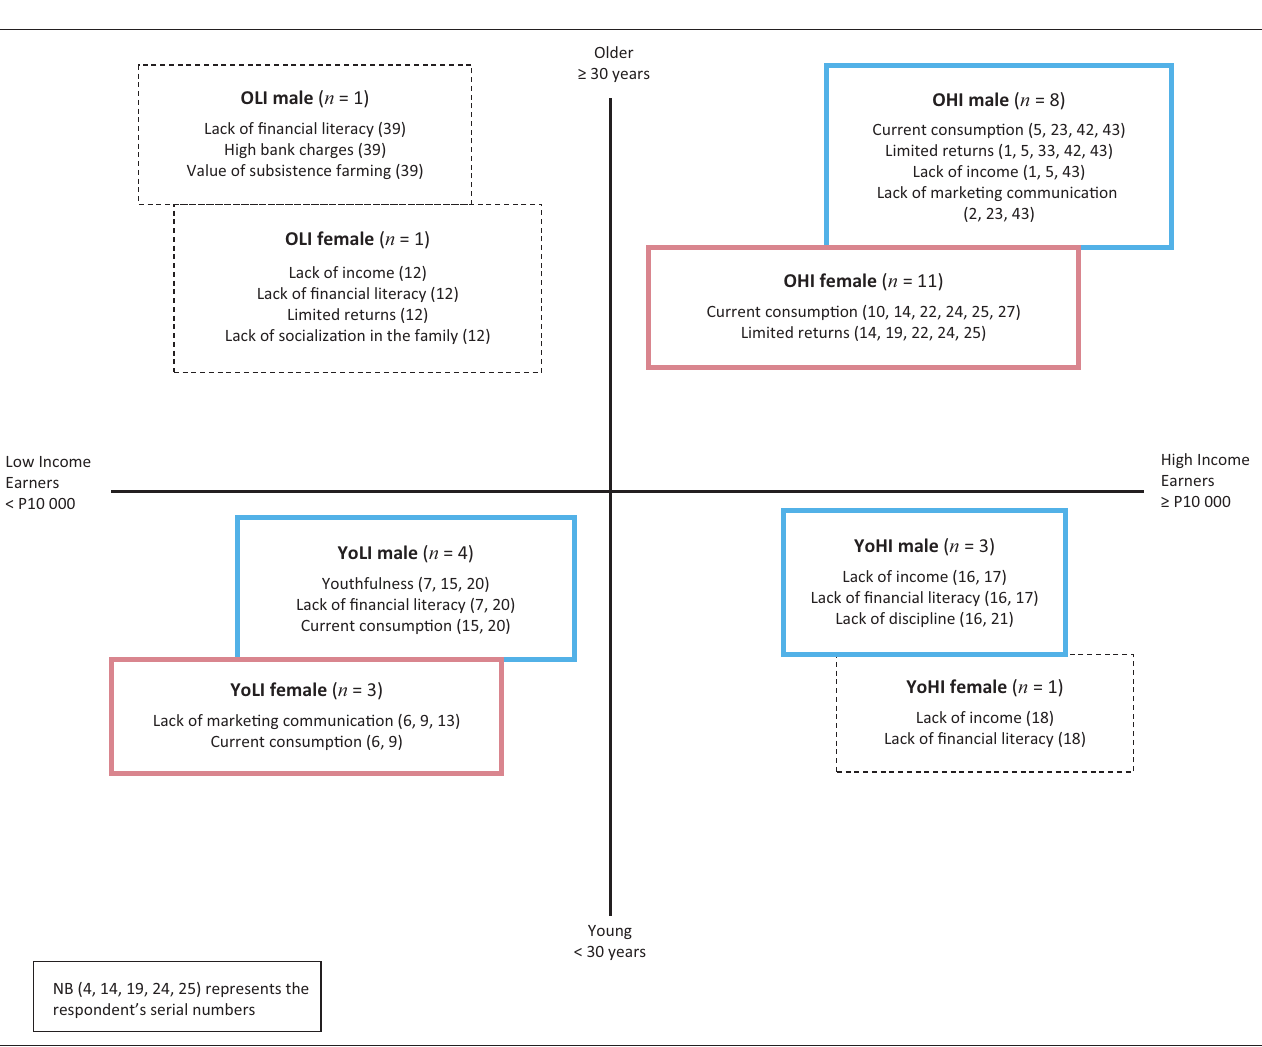
FIGURE 4: Perceived conditions affecting